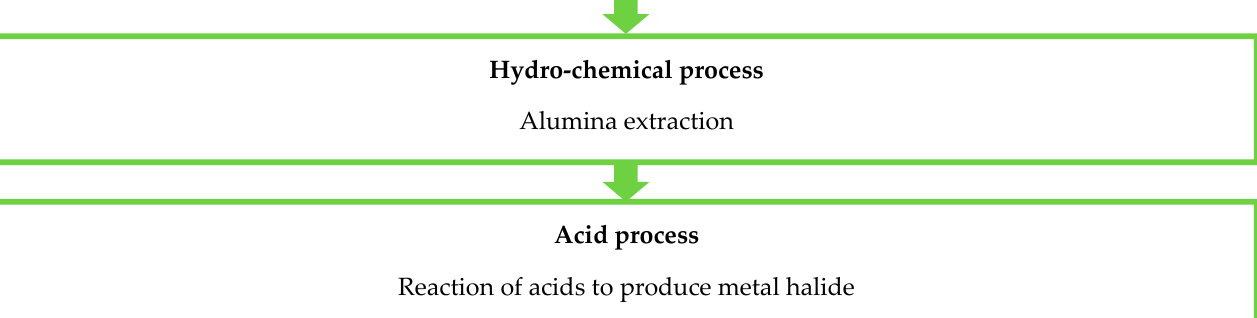
Figure 2. The process of alumina extraction from coal fly ash (CFA).